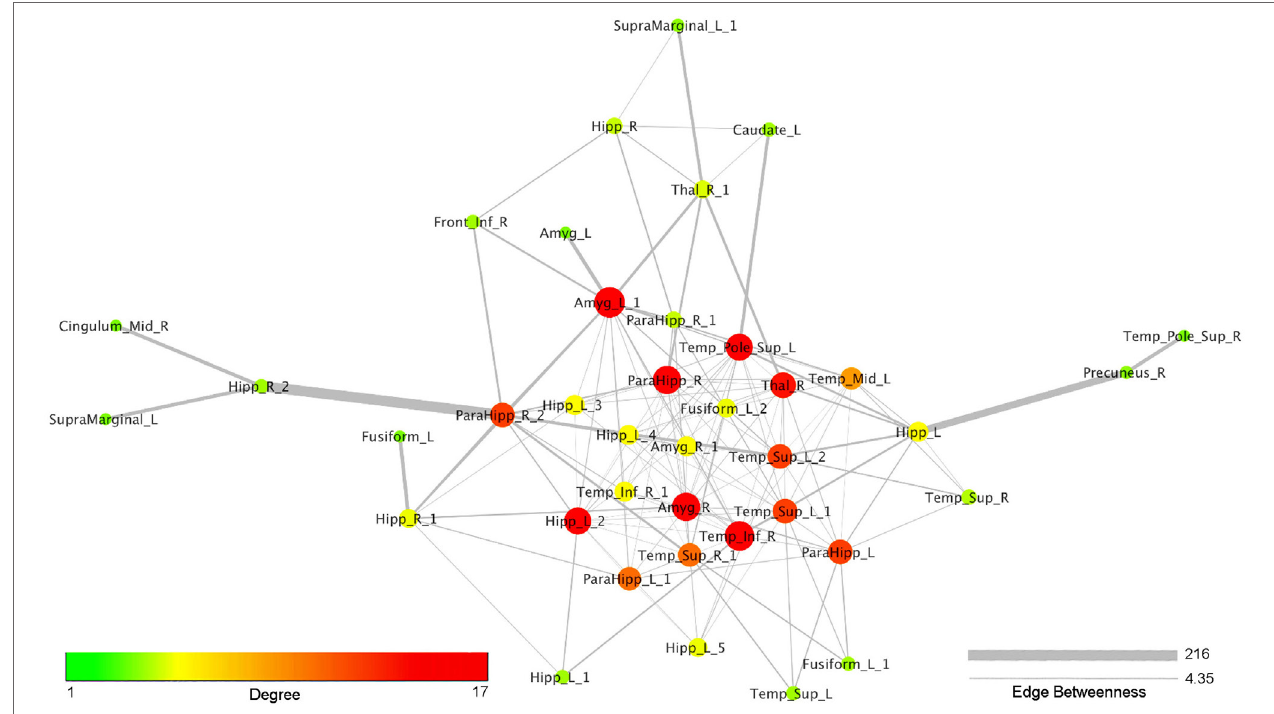
FigUre 4 | Topological analysis of the coatrophy network of Alzheimer’s disease (organic yFiles Layout). Colors and dimensions of nodes indicate their topological degree (smaller node = lower degree; from green to red = from lower to higher values). Thickness of edges indicate the degree of edge betweenness (smaller edge = lower degree).